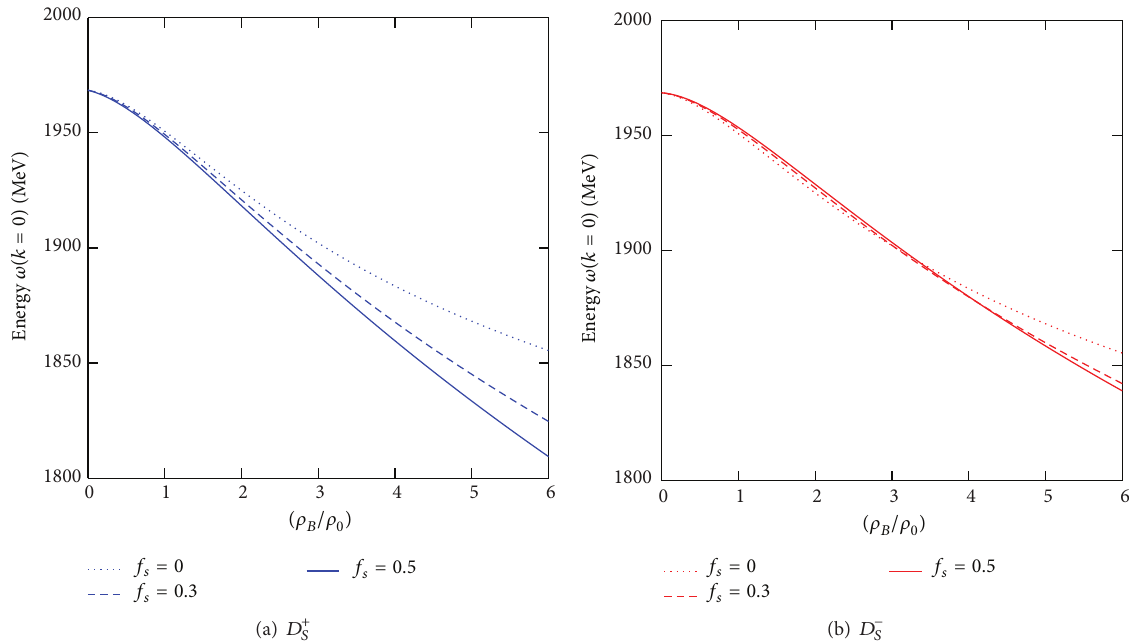
Figure 4: The sensitivity of the medium mass of (a) 𝐷 + 𝑆 and (b) 𝐷 − 𝑆 mesons, to the strangeness fraction 𝑓 𝑠 , at typical values of temperature ( 𝑇 = 100 MeV) and isospin asymmetry parameter ( 𝜂 = 0.5 ).